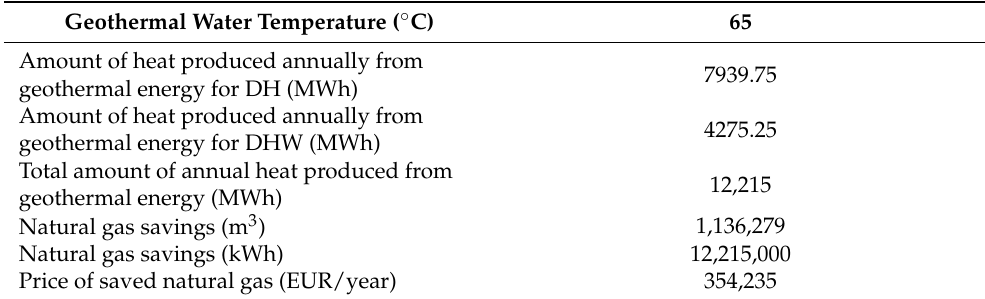
Table 5. Evaluation of the energy potential of a geothermal well in a conservative scenario with a water temperature of 65 ◦